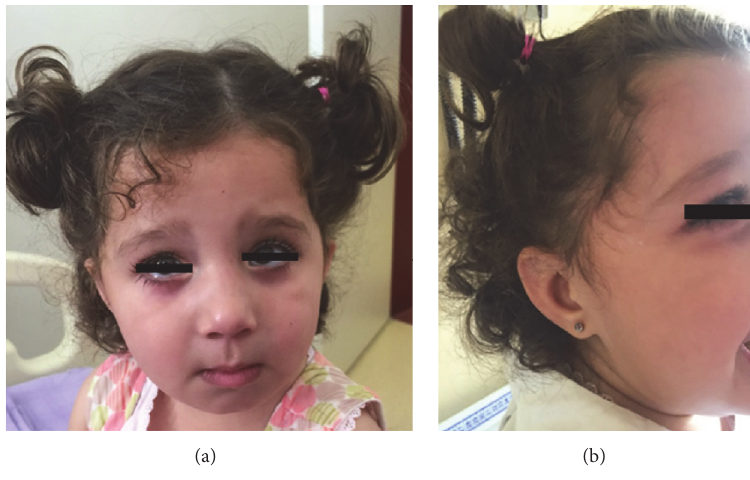
Figure 4: Dysmorphic facial features in Case